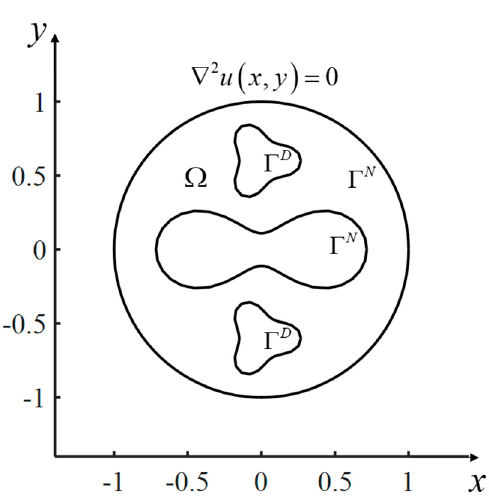
Figure 5. Schematic diagram of computational domain in Case 2.